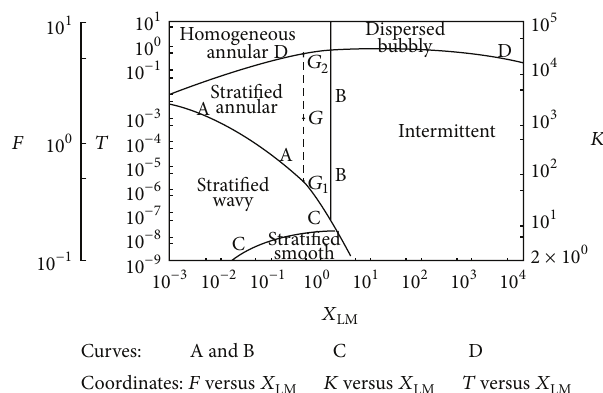
Figure 5: Modified, generalized, flow-regime map for horizontal flow [13].